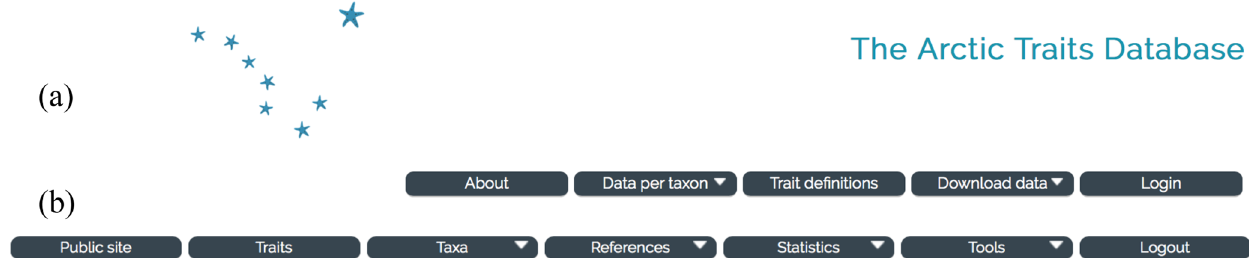
Figure 2. Screenshots of the start page of the Arctic Traits Database. Toolbar of the public page with the login button for the registered user (a) and toolbar in the area for registered users (b) .